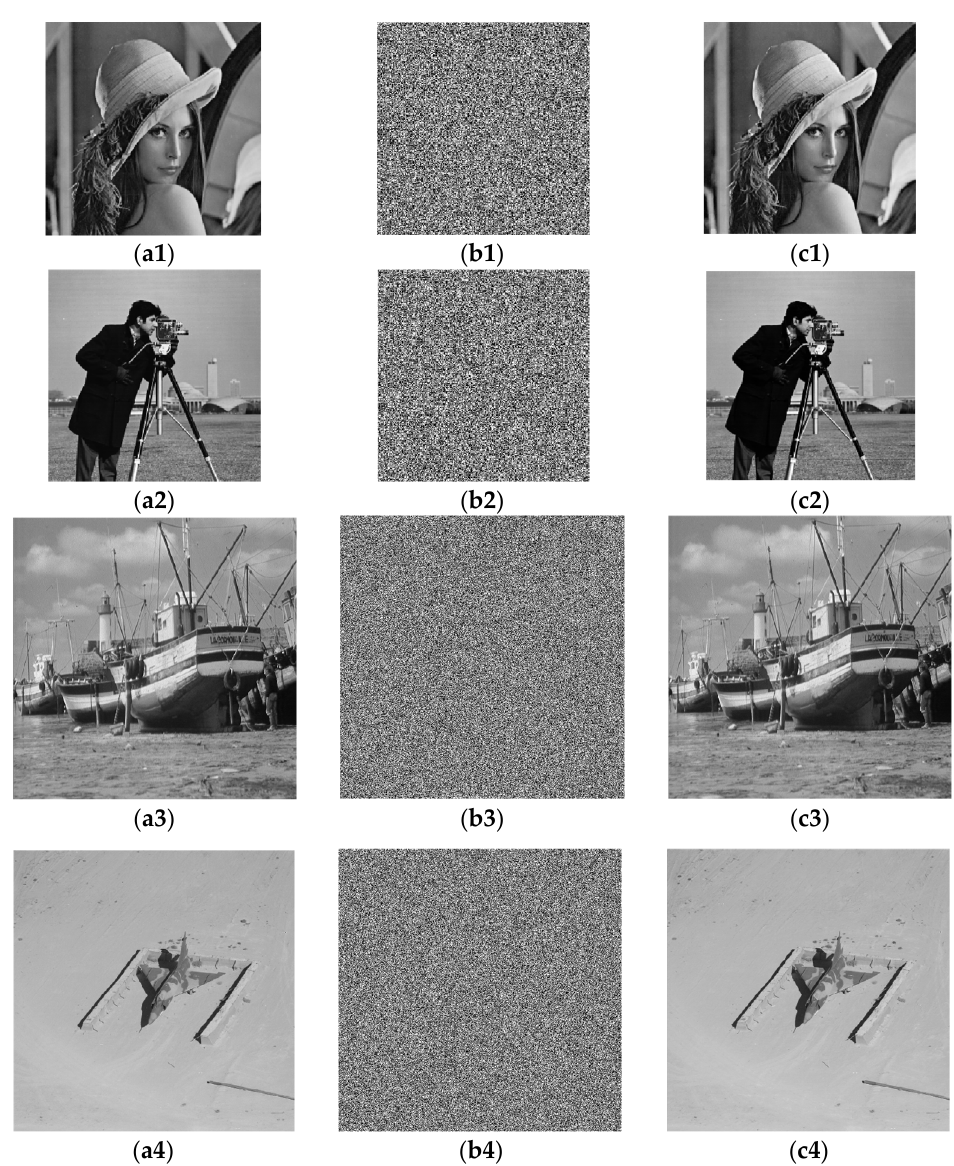
Figure 6. Experimental simulation. ( a1 – a4 ) Plaintext images; ( b1 – b4 ) Ciphertext images; ( c1 – c4 ) Decrypted images.